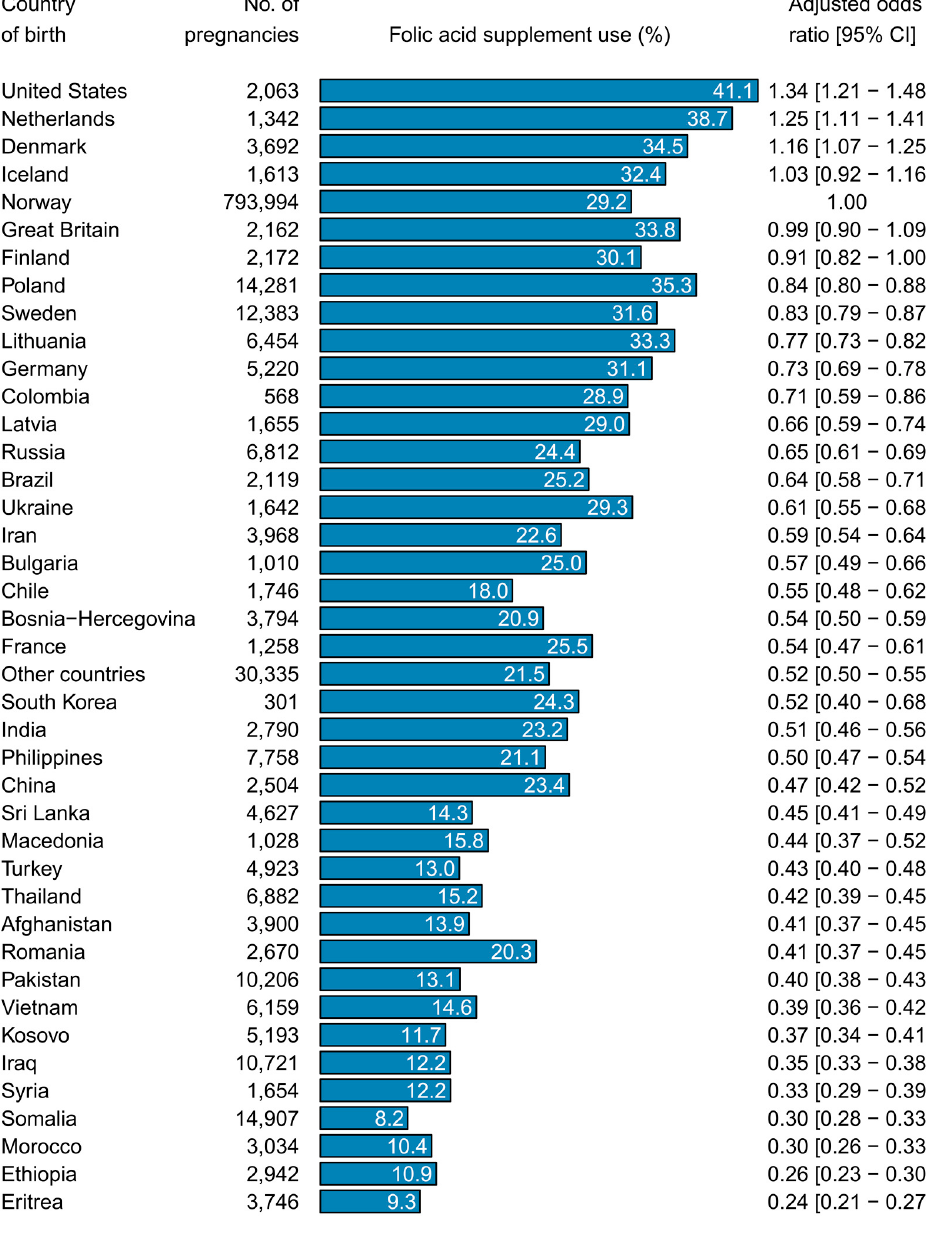
Figure 2. Percentages and odds ratios for preconception folic acid supplement use in 1st generation immigrant women by maternal country of birth (1999–2016). The reference group was Norwegian-born women with two Norwegian-born parents (non-immigrants; Norway). Odds ratios were adjusted for year of birth, maternal age, marital status, parity, geographical region, education, and income. CI indicates confidence interval.